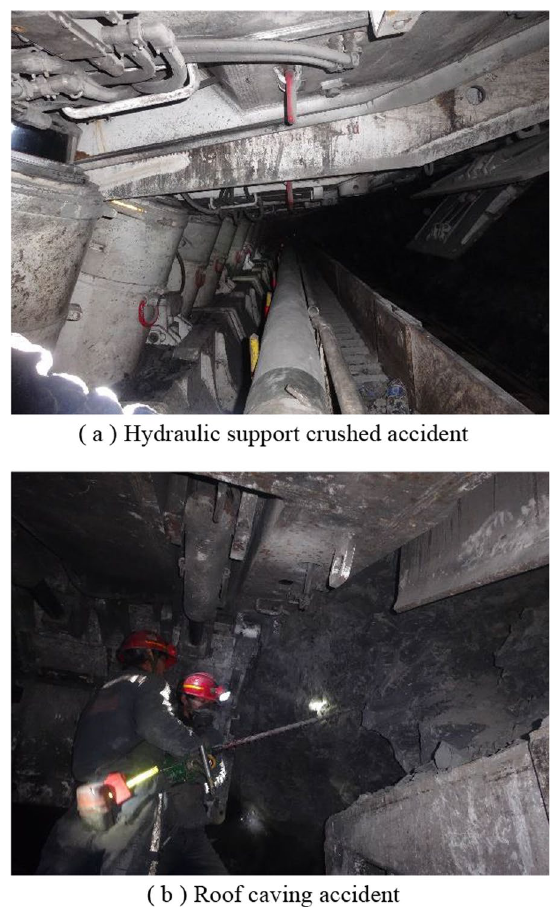
Fig. 2 Examples of roof safety accidents of the longwall